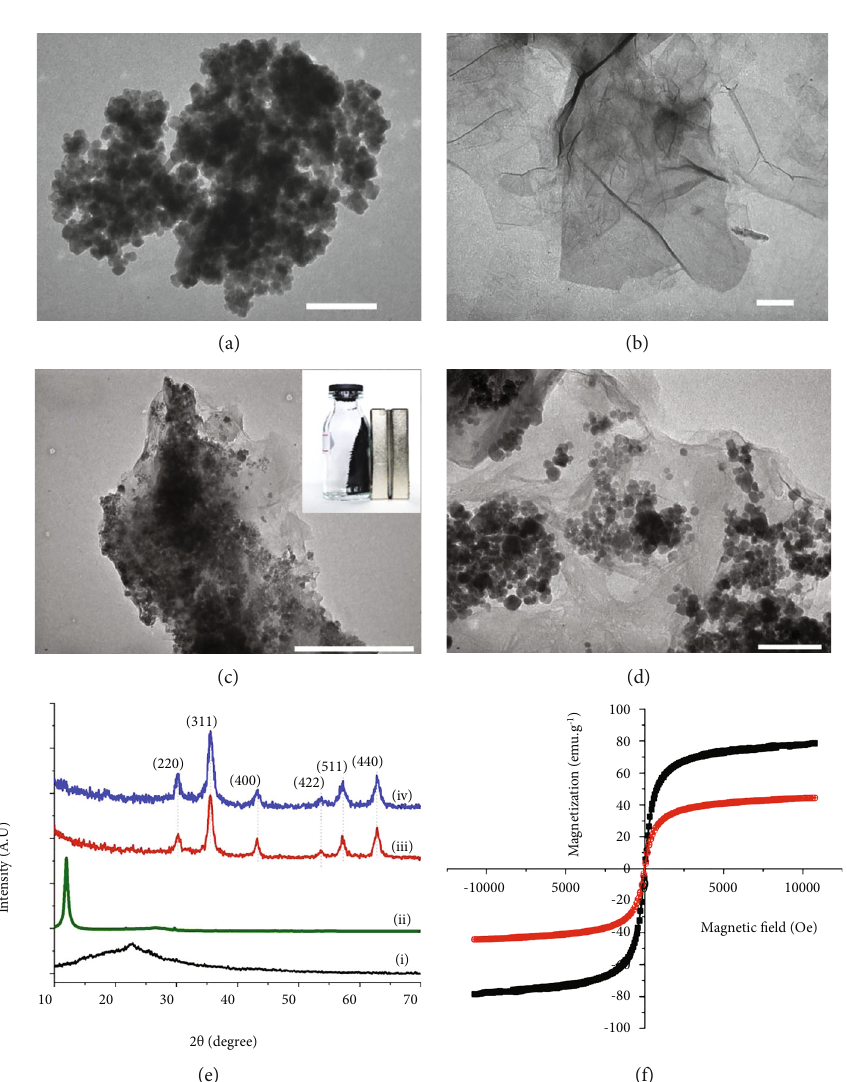
Figure 1: (a – d) TEM images of (a) Fe of GFC nanocomposite); (d) XRD patterns of (i) CS, (ii) GO, (iii) Fe